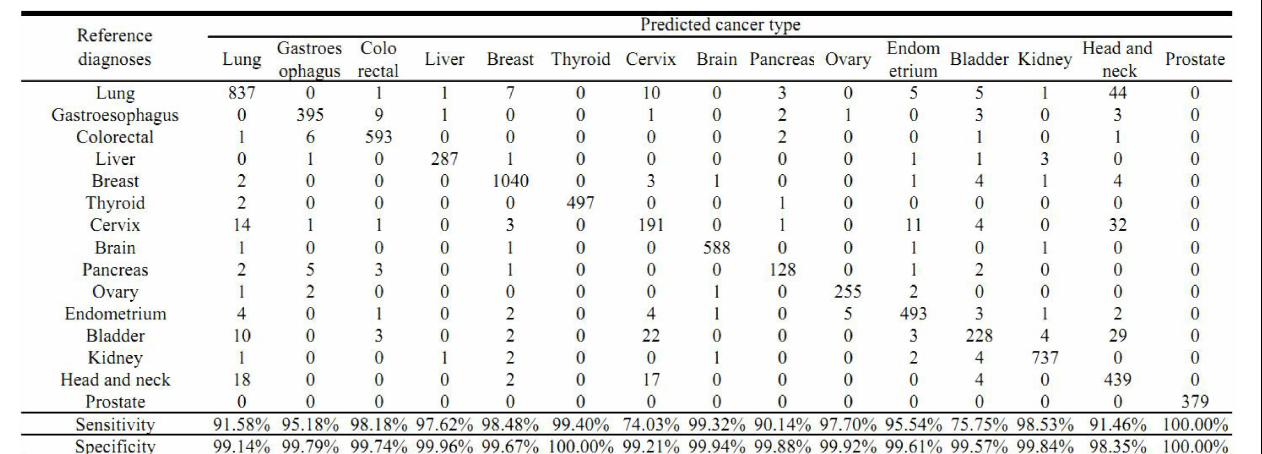
FIGURE 3 | Prediction of cancer type by confusion matrix analysis. The confusion matrix is from one 10-fold cross validation and displayed the relationship between reference diagnosis and the predicted cancer type. The first column represents reference diagnoses; the predicted cancer types by transcript levels of the 150 genes are shown across the top